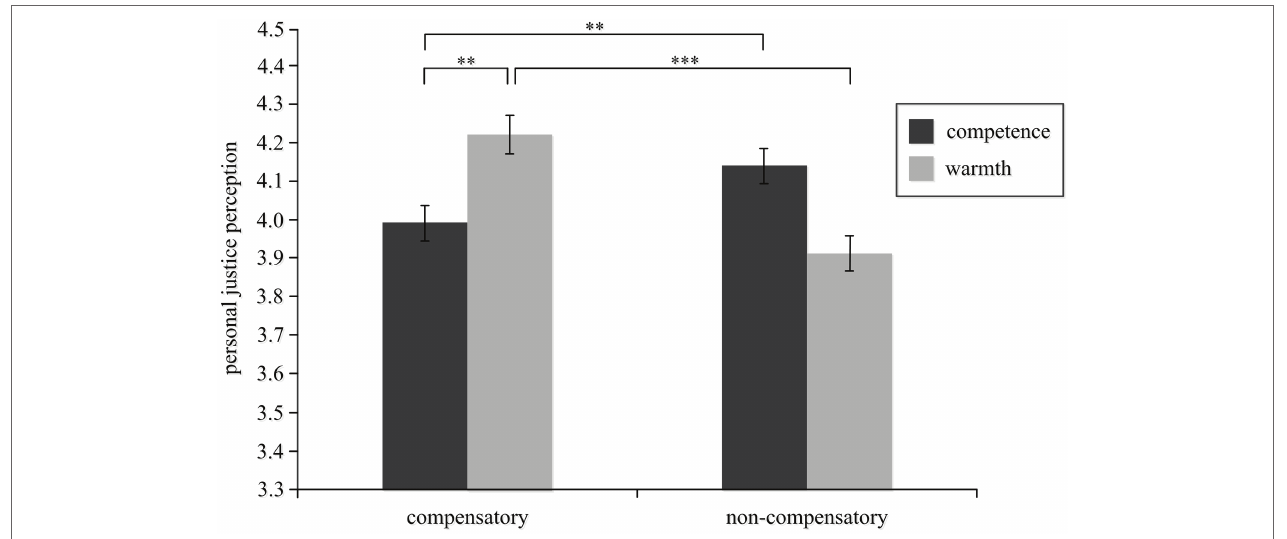
FIGURE 1 | Effects of compensatory stereotypes on different dimensions on personal justice perception. ** p < 0.01, *** p < 0.001.